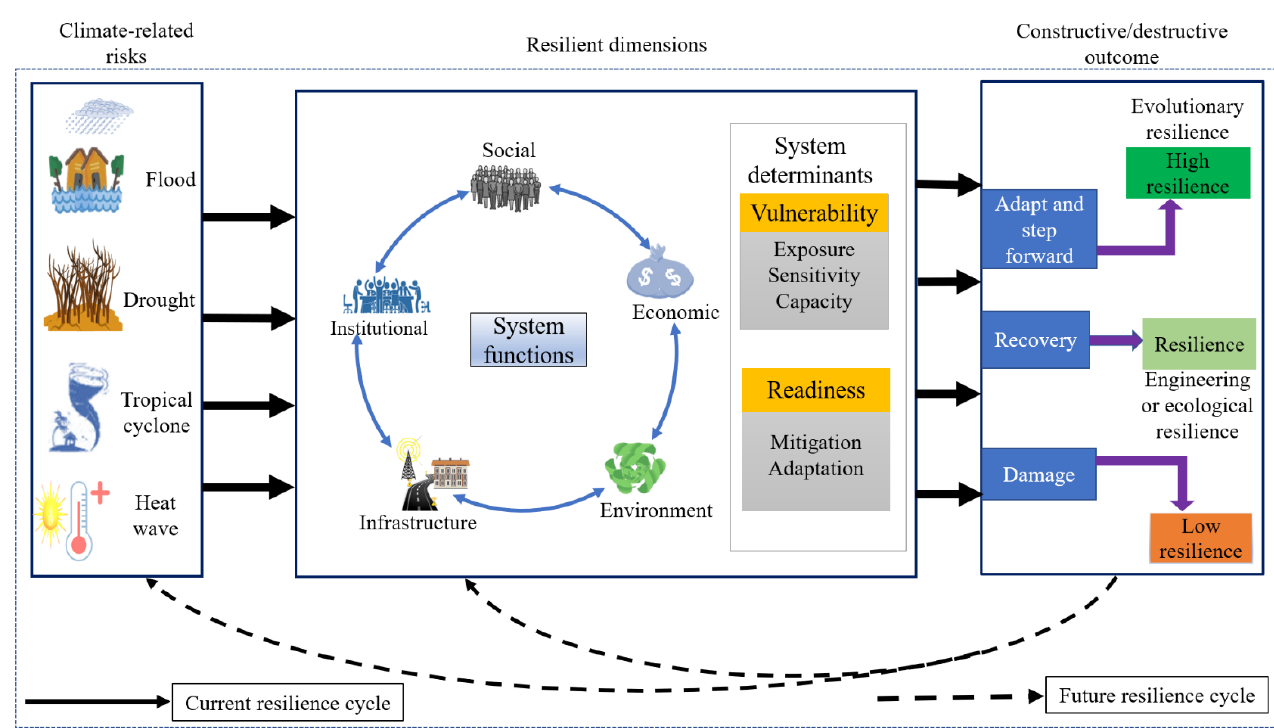
Figure 1. The graphical representation of the climate resilience framework of the study.